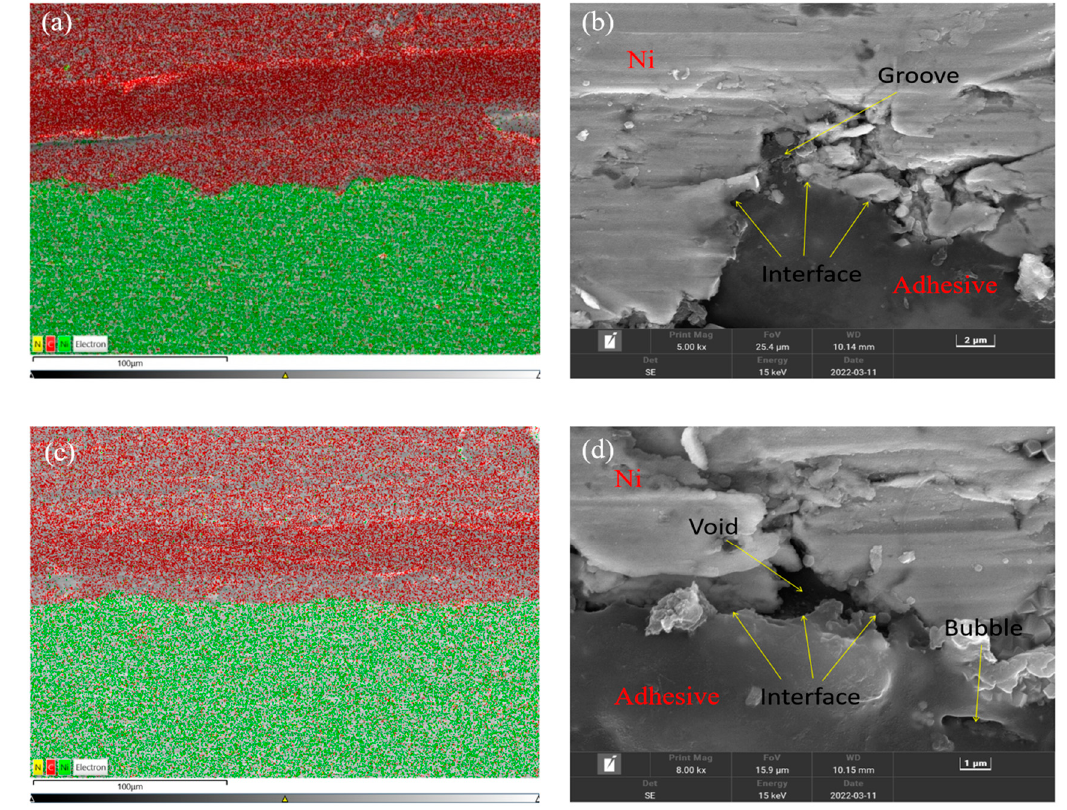
Figure 10. EDS mapping images of the interface ( a ) with and ( c ) without the ultrasonic treatment, and SEM images of the interface ( b ) with and ( d ) without the ultrasonic treatment.